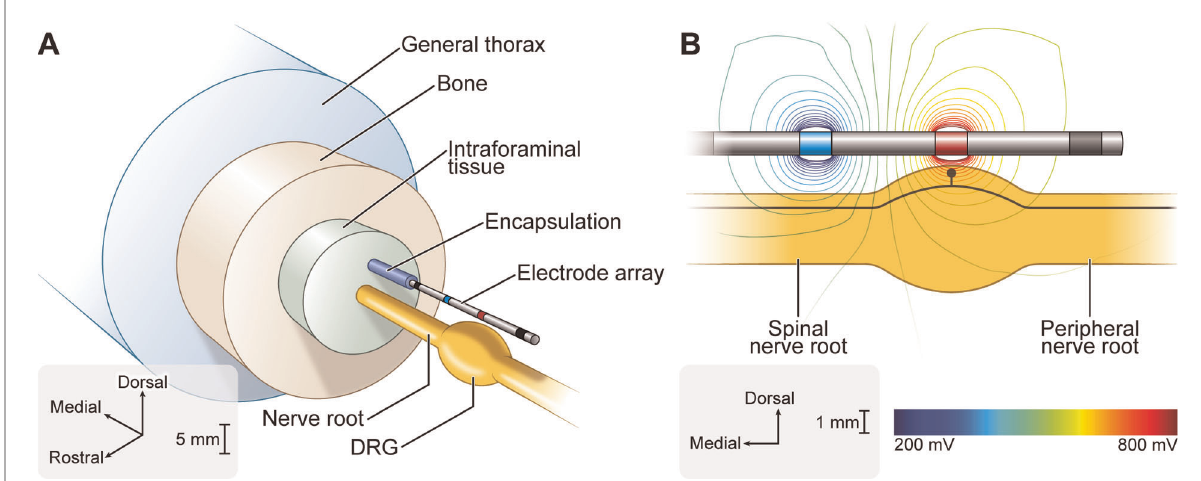
FIGURE 1 Finite element method (FEM) model of DRGS. We developed an FEM model of a human L5 DRG and surrounding anatomy. We implemented our previously published FEM model of DRGS (12). We included a model of a four-contact DRGS electrode array oriented above the DRG. ( A ) Exploded view of the DRGS FEM model. ( B ) We used the FEM model to calculate the extracellular potentials generated by DRGS. The trajectory of a model C-neuron is indicated by the black trace within the